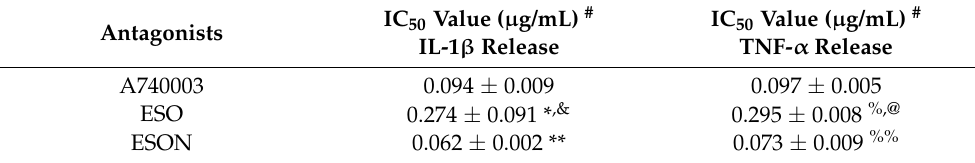
Table 4. ESO and ESON inhibited the ATP-induced cytokines in mouse cells.